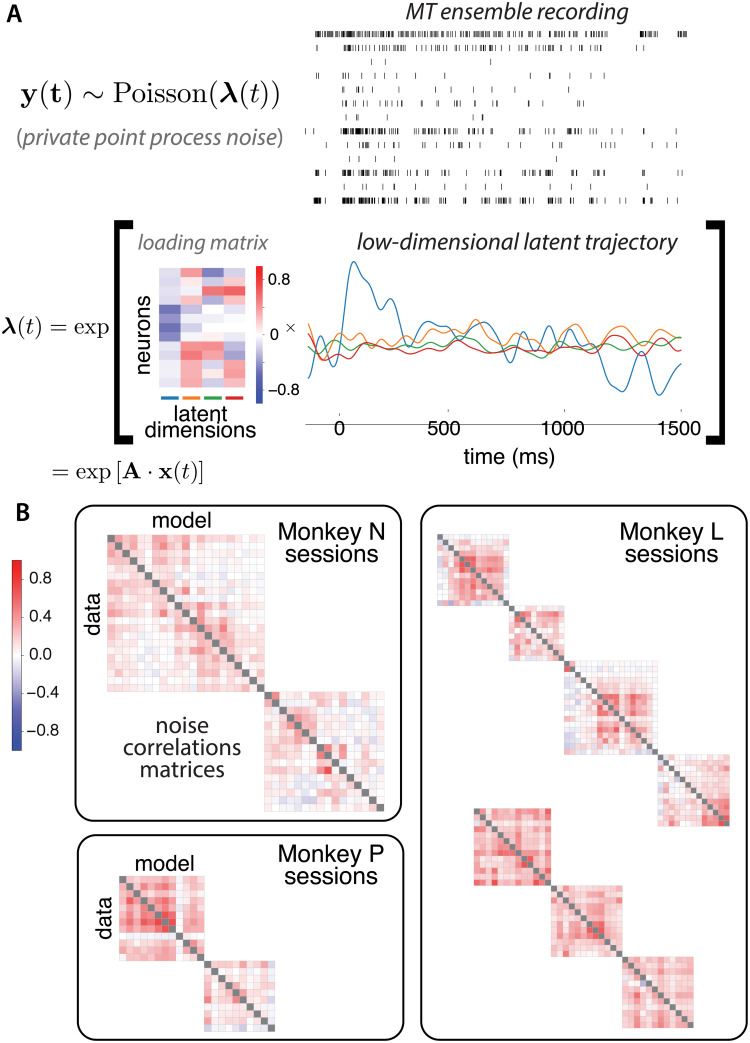
Probabilistic description of a single trial using variational latent Gaussian process method and resulting noise correlation.(A; top) Simultaneously recorded spike trains of the MT units in an example trial aligned to stimulus onset (yt in Eq 2). (A; bottom) Corresponding 4-dimensional factors. The rank-4 matrix multiplication of the loading matrix (matrix A in Eq (2)), and latent factors are exponentiated to produce the population rate. The loading matrix is rotated to maximize stimulus encoding (see Fig 4), so that the first column has the strongest stimulus response. The inferred latent factors (xt in Eq (2)) are colored to indicate the respective factors corresponding to the loading matrix. (B) The pairwise noise correlation matrices (neuron by neuron) for the sessions with frozen trials (trials with identical stimulus). The lower triangles are the correlations calculated from the raw data, and the upper triangles are the correlations from the reconstruction by the inferred 4-dimensional latent factors. Time bin size 100 ms.